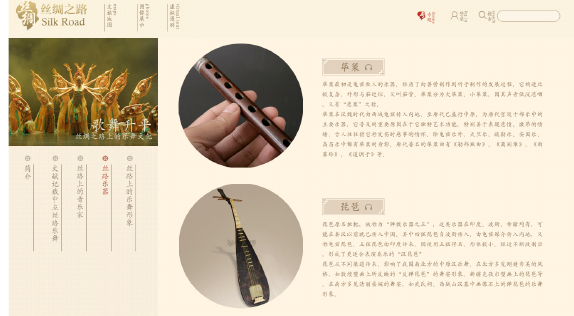
Figure 8: Example of detailed information about Musical Instruments under “topic” of the